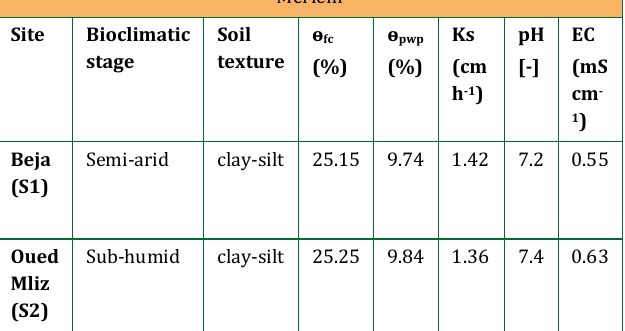
Table 2: Physical and hydrodynamic soil characteristics of Chott